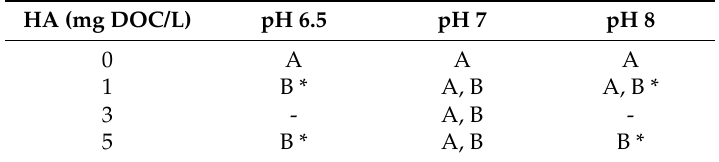
Table 4. Experimental conditions used for the experiments shown in Figures 5 and